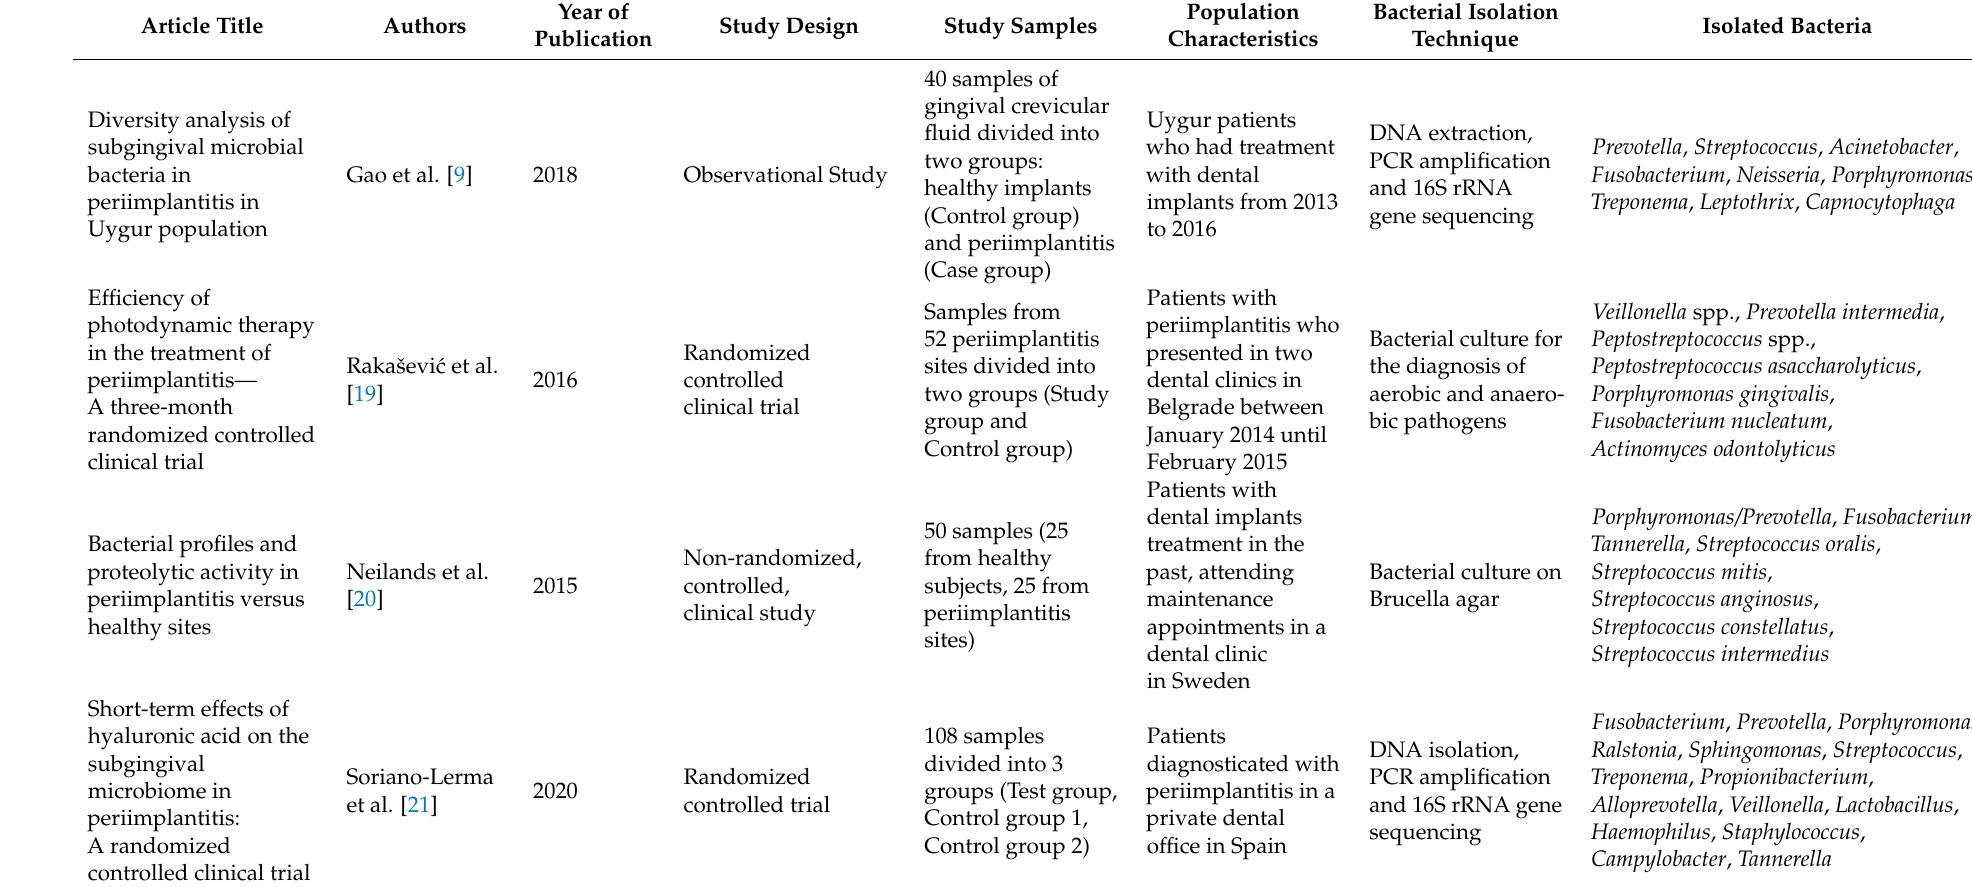
Table 1. Studies included in this review and the main bacterial species identified in each